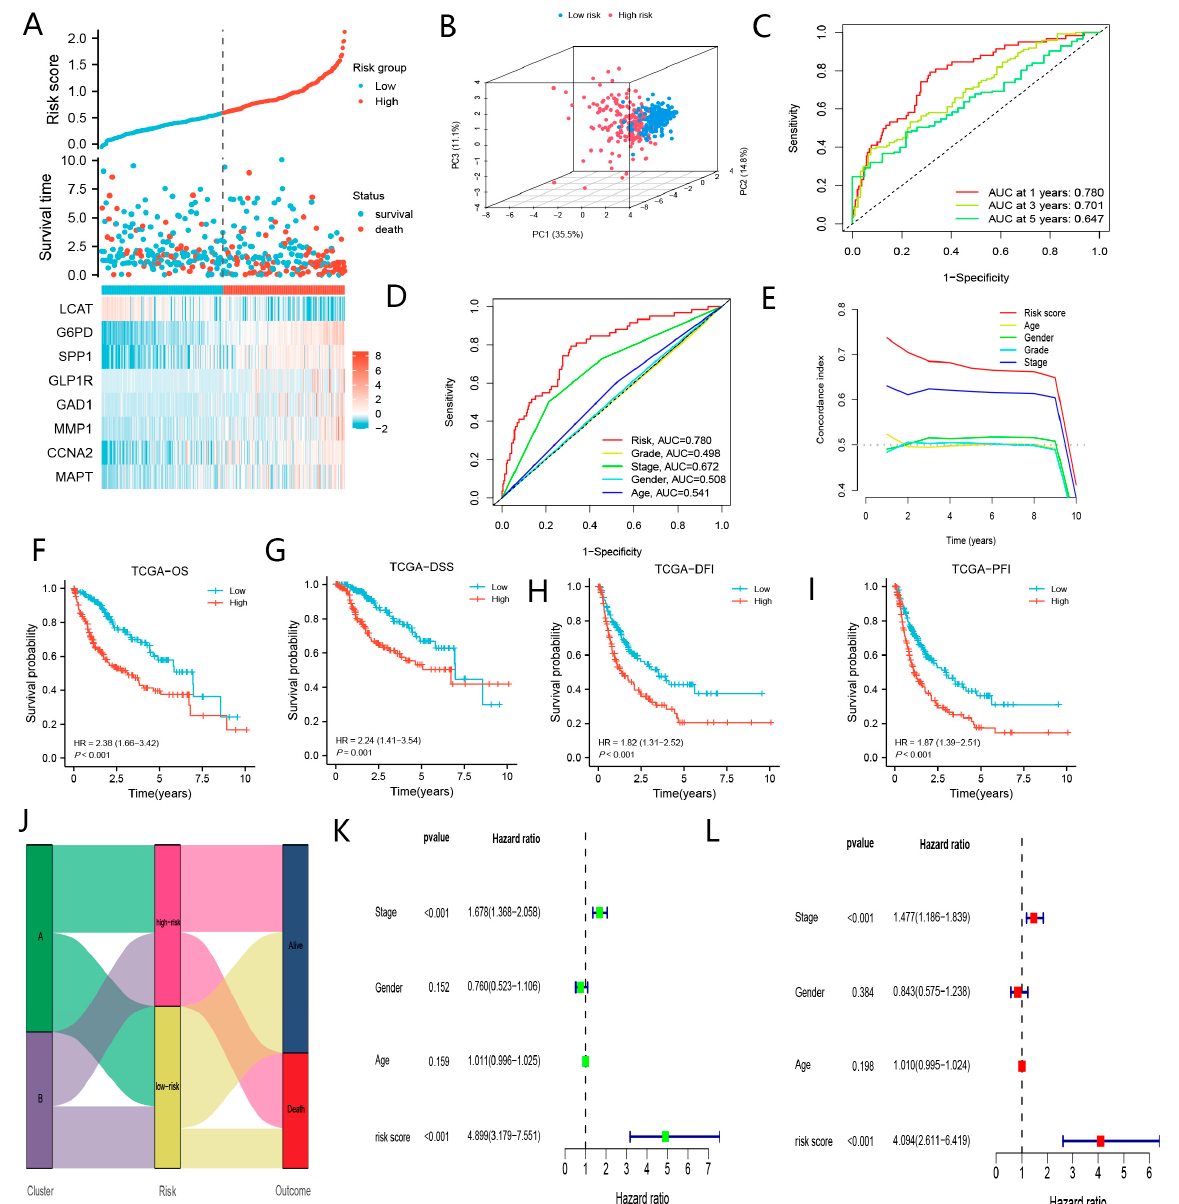
Figure 6. The excellent predictive performances of BMGs in TCGA-LIHC. ( A ) The risk score distri- bution plot. ( B ) PCA analysis of low- and high-risk groups. ( C ) The timeROC curve of BMGs in predicting the prognoses of HCC. ( D ) The ROC curve of risk score, TNM-stage, age, and gender in predicting the prognoses of HCC. ( E ) The c-index curve of risk score, TNM-stage, age, and gender in predicting the prognoses of HCC. ( F ) KM curve of OS for patients in low- and high-risk groups. ( G ) KM curve of DSS for patients in low- and high-risk groups. ( H ) KM curve of DFI for patients in low- and high-risk groups. ( I ) KM curve of PFI for patients in low- and high-risk groups. ( J ) Sankey plot summarized the correlation among the clusters, BMGs, and survival status. ( K ) Univariate Cox analysis of risk score, TNM-stage, age, and gender. ( L ) Multivariate Cox analysis of risk score and